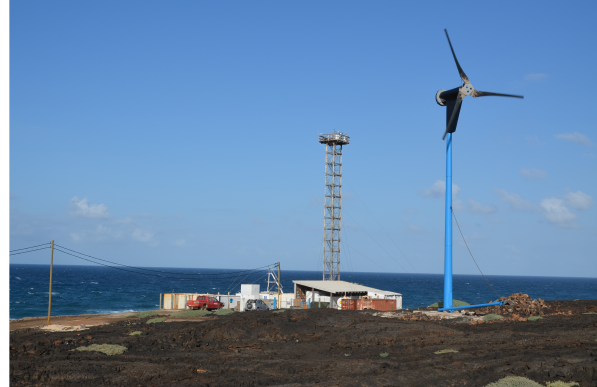
Fig. 1. CVAO station situated at the coastline of the Sao Vicente Island in the northern tropical Atlantic with clear view of the 30 m high measurement tower, some measurement containers, and a wind turbine for subsidizing electrical